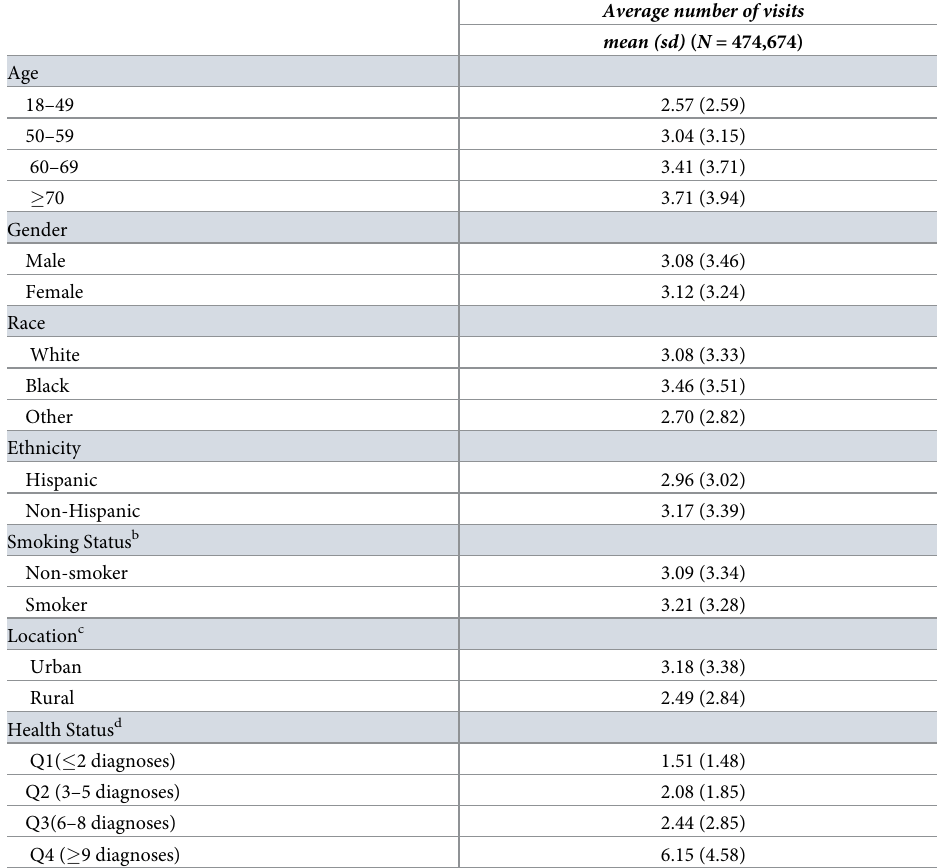
Table 2. Healthcare utilization across patient characteristics a